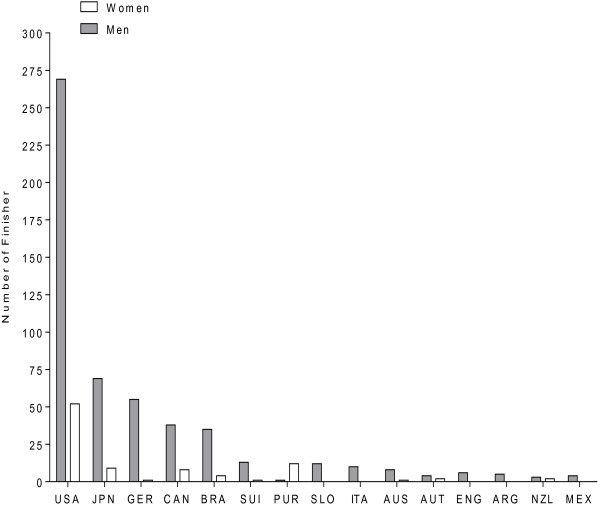
Number of male and female finishes per country in Ultraman Hawaii between 1983 and 2012. The frame indicates the 15 countries with the highest number of male and female finishes. Athletes from these 15 countries accounted for 92.7% of all finishers.